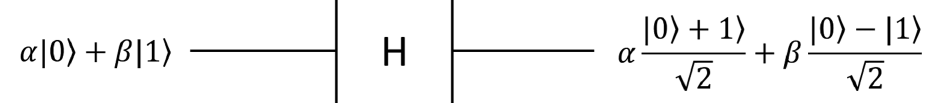
FIG. 6. CNOT gate.